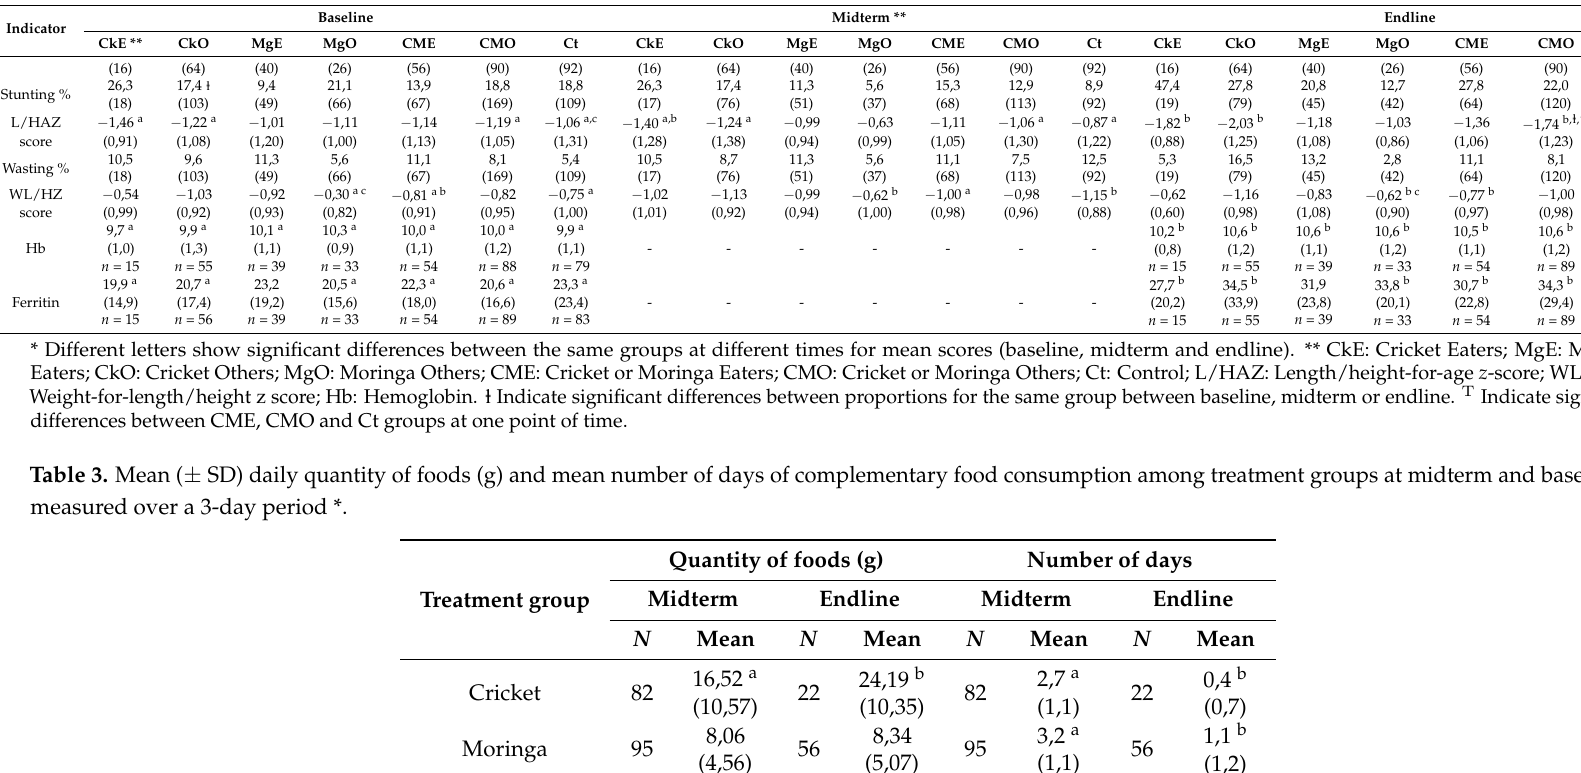
Table 1. Description of the population at baseline, midterm and endline *.